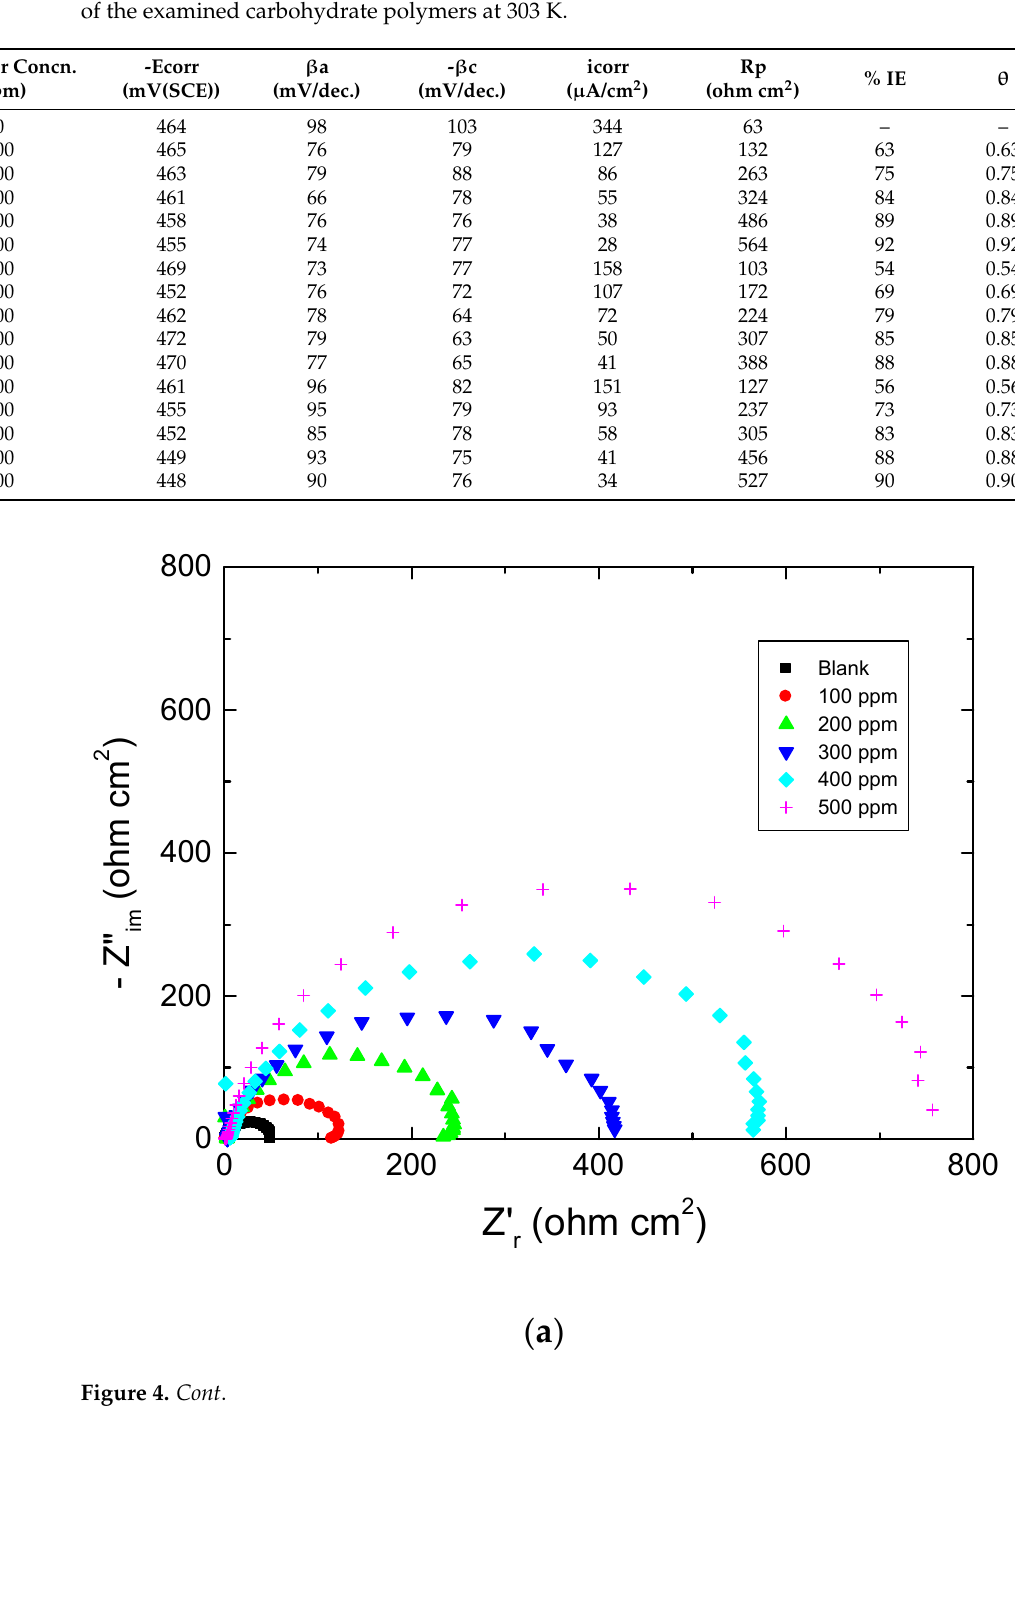
Table 1. Corrosion parameters for mild-steel corrosion in 0.5 M HCl solution in absence and presence of the examined carbohydrate polymers at 303 K.